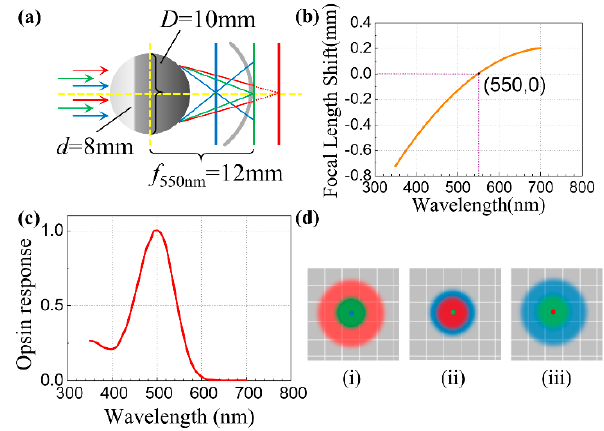
Figure 1. Optical model and characteristics of chromatic aberration. ( a ) Optical path diagram of the model that reflects a high longitudinal chromatic aberration characteristic. ( b ) Longitudinal chromatic aberration curve with a focal length shift range of approximately 0.923 mm in the wavelength range of 350–700 nm. ( c ) Photoreceptor response curve. Octopus retina contain only one type of photoreceptor and exhibit almost no response to light exceeding 600 nm. ( d ) Diagrammatic drawing of a point object with three wavelength bands at the distance of infinity imaged on the detection plane containing. The photoreceptor response is not considered here; (i), (ii), and (iii) indicate the focal plane at each wavelength band.